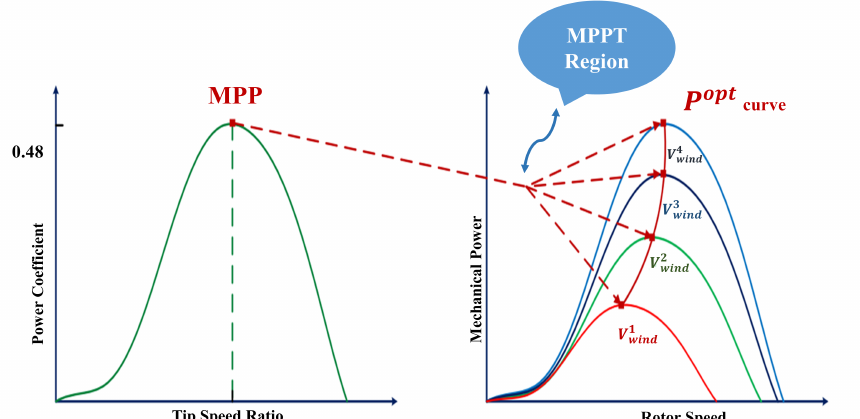
Figure 4. WT characteristics for λ opt and C popt . This figure is adapted with permission from Ref. [48]. Copyright 2021,